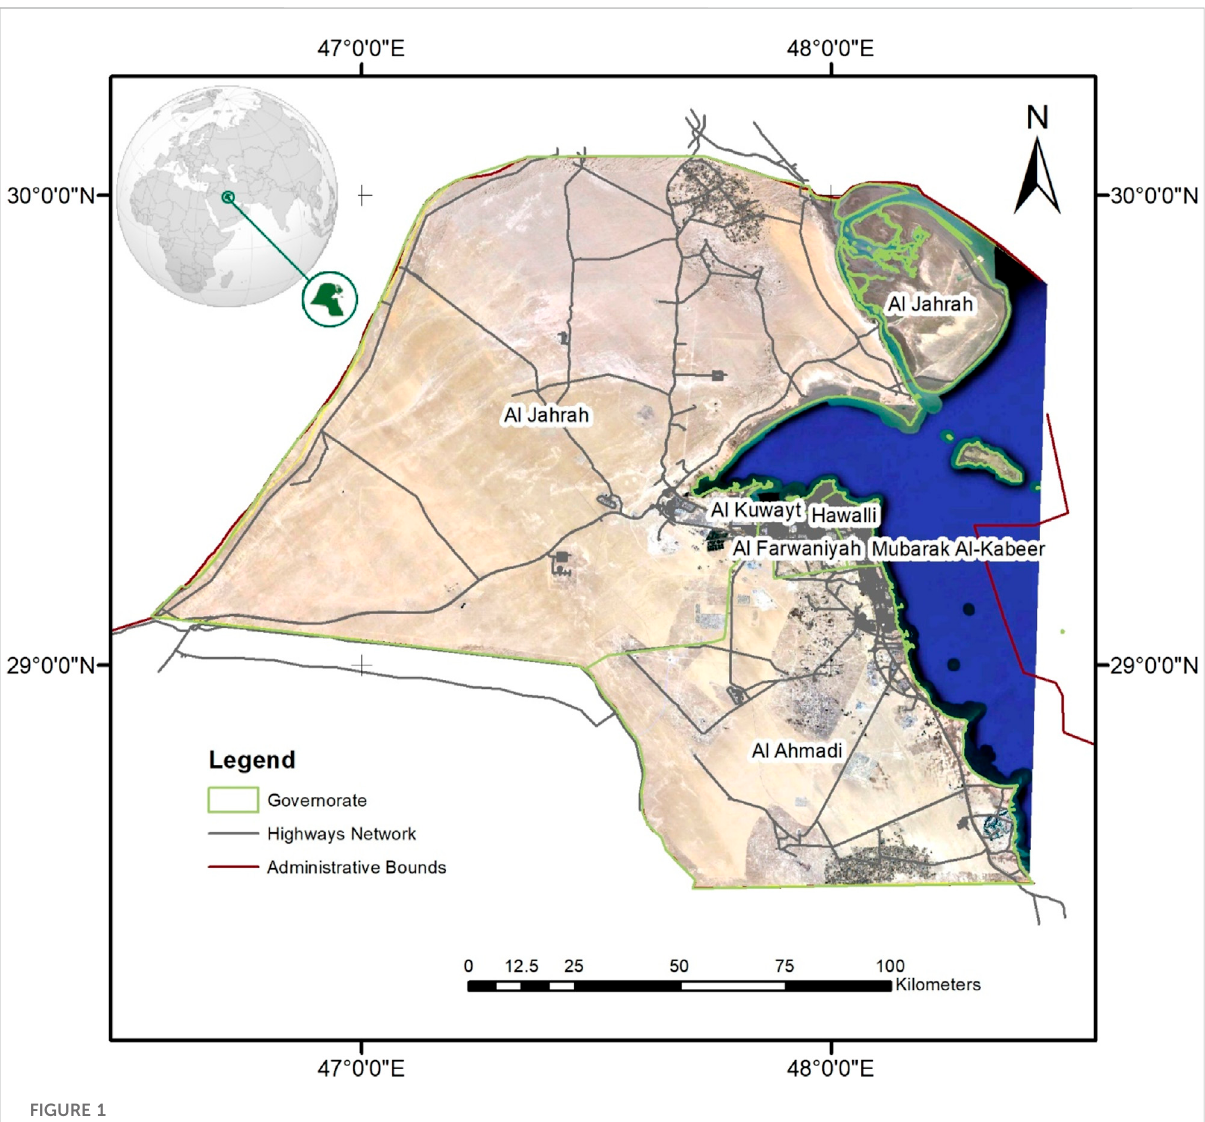
FIGURE 1 Location, map, and governates of